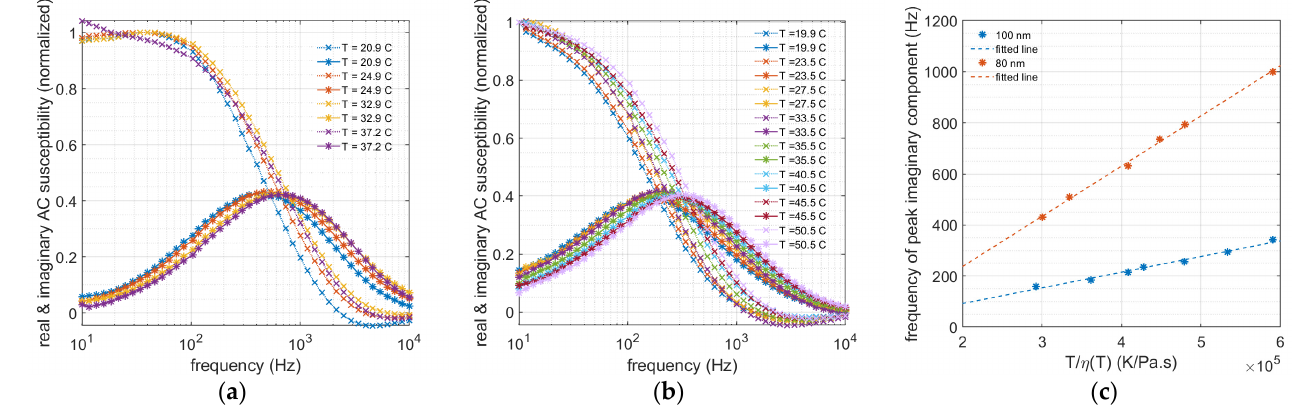
Figure 3. Normalized AC susceptibility of ( a ) 80 nm and ( b ) 100 nm MNP tracers versus magnetic excitation frequency plotted at different temperatures. ( c ) Frequency of peak imaginary component for both 80 nm and 100 nm MNPs at various temperatures plotted against T / η ( T ) shows a linear dependence. Table 1. Hydrodynamic particle diameters (volume-weighted) and their geometrical standard de- viations at each temperature for both 80 and 100 nm nanoparticles extracted from fitting the AC susceptibility measurement data with the generalized Debye model. The effect of temperature on the viscosity of water is estimated from the empirical formula given by Equation (4). The 80 nm and 100 nm sizes refer to number-weighted hydrodynamic particle